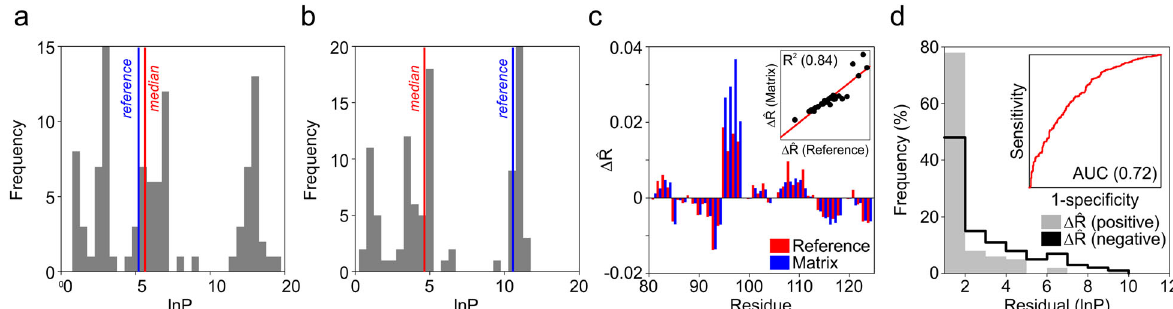
Fig. 3 Validating the accuracy of model lnP for residues. a , b Example optimisation histograms for two residues with high ( a ) and low ( b ) accuracy. The grey bars show the frequency of different lnP bins for an optimisation performed with 100 replicates ( n = 100) along with the reference and median lnP reported as blue and red lines, respectively. c Bar chart showing the relationship between Δ R ̂ -reference (red) and Δ R ̂ -matrix (blue) values for each residue over a single HDX-MS reference dataset. The Δ R ̂ -matrix value of each residue reports the change in R ̂ -matrix following its elimination from the dataset with Δ R ̂ -reference referring to changes in R ̂ -refence following deletion. Plot shows the equivalence between Δ R ̂ -matrix and Δ R ̂ -reference with an R 2 value of 0.84 (insert). d Histogram of residual lnP for the modelled data separated into positive (grey bars) and negative (black line) Δ R ̂ -matrix values. Plot demonstrates 60% enrichment of highly accurate modelled values, within ± 1.0 lnP of reference data, for residues with a positive Δ R ̂ -matrix. Conversely, residues with negative Δ R ̂ -matrix values are 300% more likely to have outlying lnP >2.0 from reference data. The inset shows the associated receiver operating characteristic (ROC) plot demonstrating the ability of the error in the modelled lnP to classify residues with positive and negative Δ R ̂ -matrix values. The accuracy of the classi fi cation is 72% taken from the area under the curve (AUC). All plots in ( d ) report the combined trend for all residues over the whole reference library of 30 different HDX-MS datasets ( n =